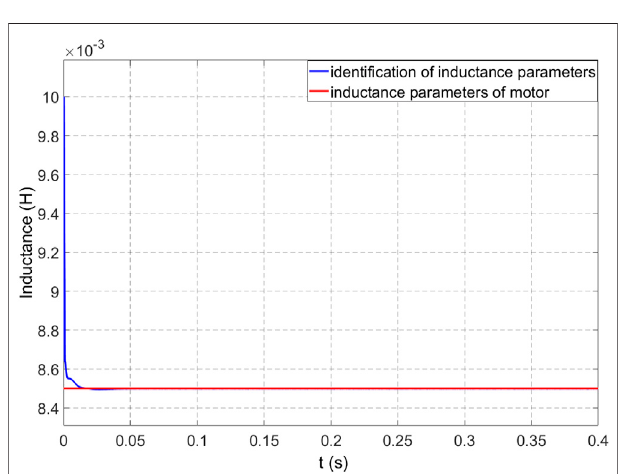
FIGURE 11 | Position estimation with parameter identi fi